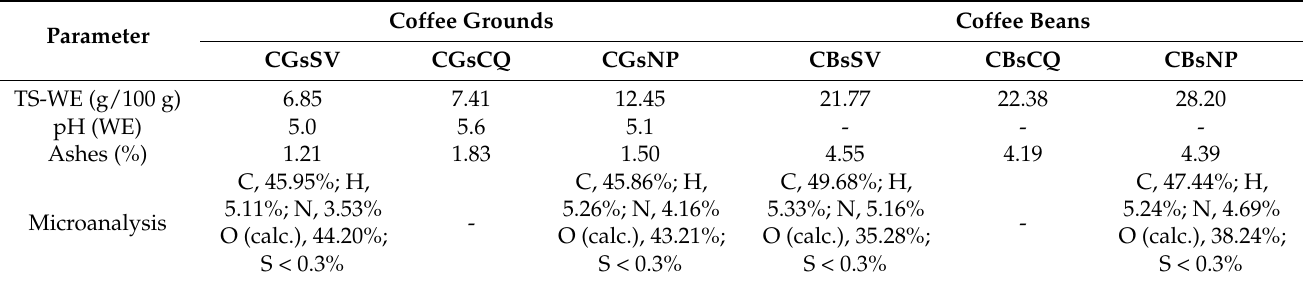
Table 1. Physico-chemical characteristics of CGs and CBs and their water